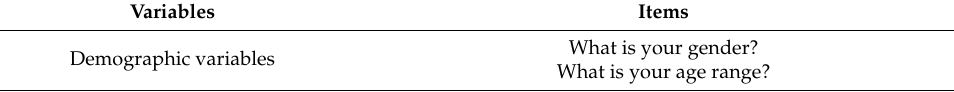
Table A1. Questionnaire